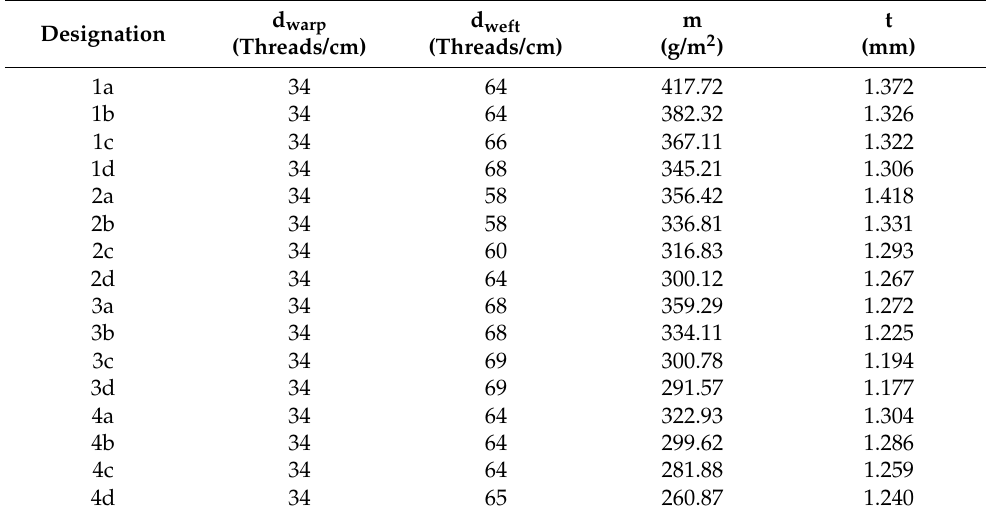
Figure 1. Structure of the layer interchanging double cloth: ( a ) fabric weave, ( b ) fabric cross-section, ( c ) fabric front side, ( d ) fabric backside. Table 3. Construction and structural parameters of the woven